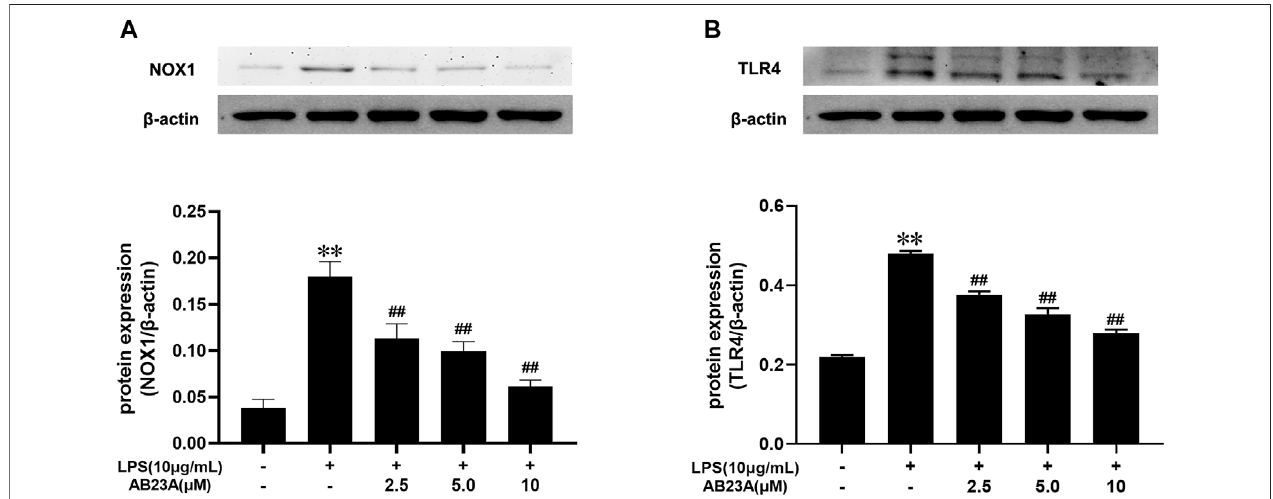
FIGURE 6 | AB23A effects on the TLR4 and NOX1 proteins expression induced by LPS. (A) The TLR4 protein expression level. (B) The NOX1 protein expression level. All gel images are from the same sample. β -actin was utilized repeatedly as a control image. ** p < 0.01 vs. control; ## p < 0.01 vs. LPS (10 μ g/ml).